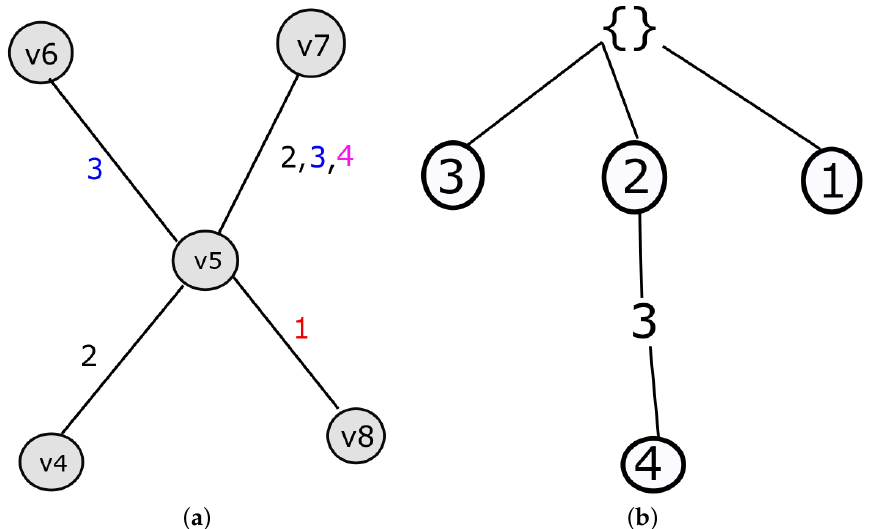
Figure 5. Building set-trie Index for data vertex v 5 . ( a ) Neighbourhood subgraph structure of v 5 , ( b ) set-trie index representation for v 5 .